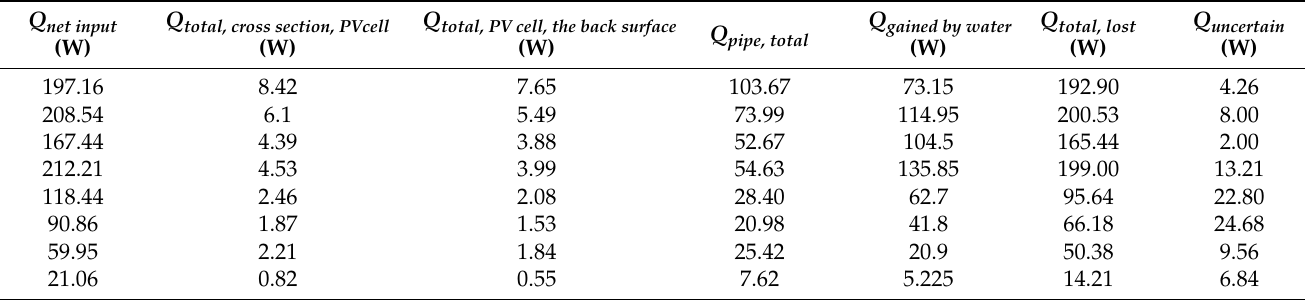
Table 10. Uncertain heat lost for different heat